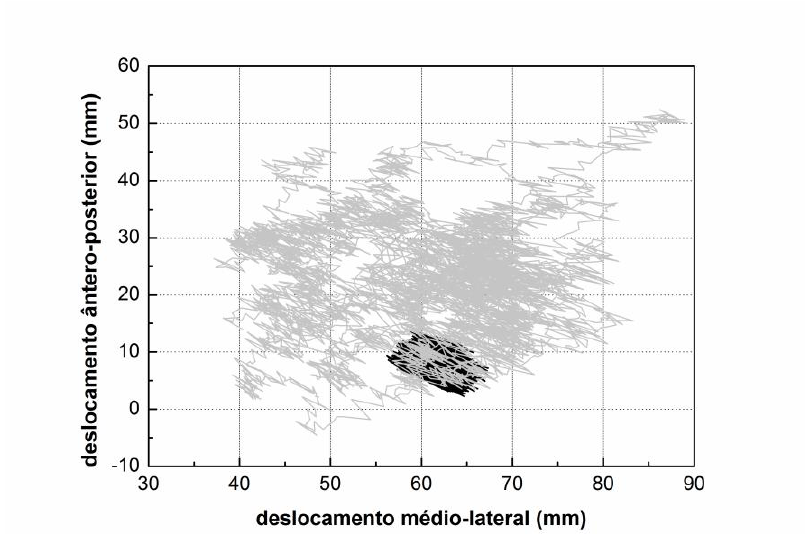
Na figura 2 é apresentado o deslocamento do CP (estabilograma) de um judoca antes e durante a realização da preensão manual, como exemplo do aumento da área de deslocamento do CP quando realizada a preensão manual.